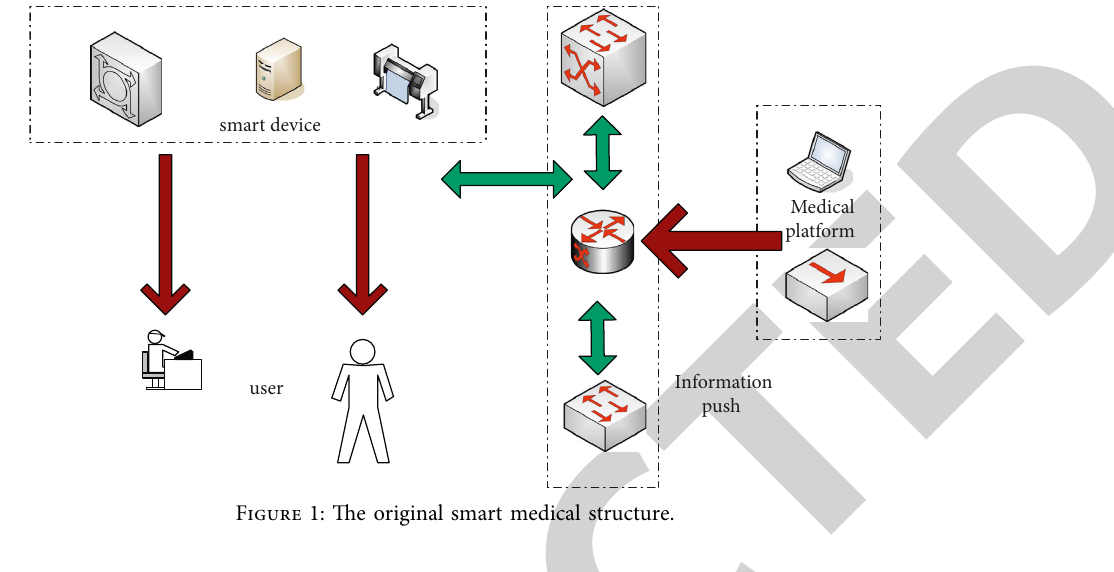
Figure 1: The original smart medical